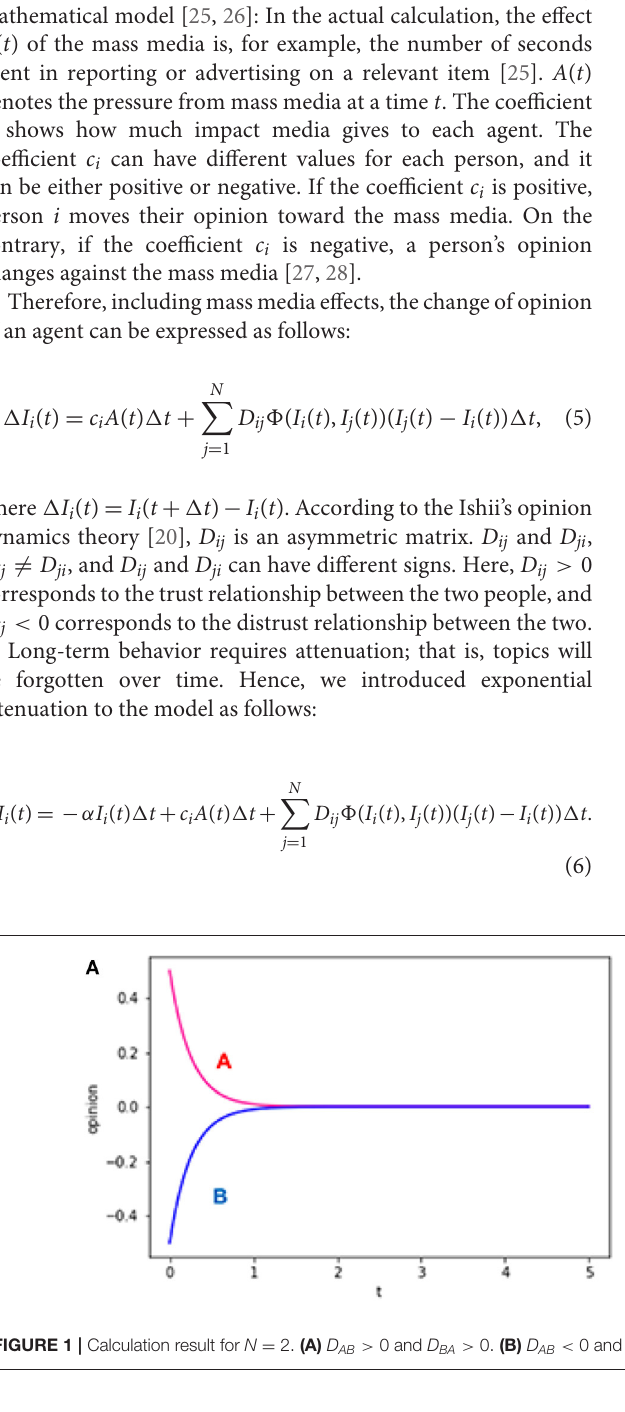
Frontiers in Physics |